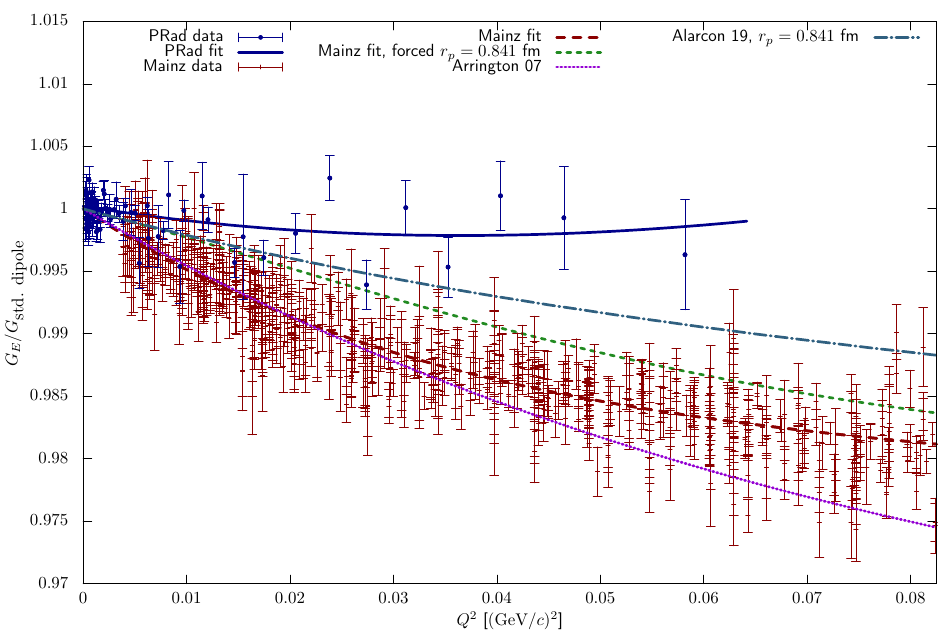
Figure 2. Extracted data and fits for G E , as the ratio to G std.dipole = (1 + Q 2 / 0 . 71(GeV / c ) 2 ) − 2 to compress the range. Shown are the PRad data and fit [45], the Mainz data, polynomial fit and experimental uncertainty [2], a fit to the Mainz data with a radius forced to the muonic spectroscopy value, an fit to pre-Mainz data [48], the theoretical calculation by Alar´con [17]. Data are normalized according to their respective fits.